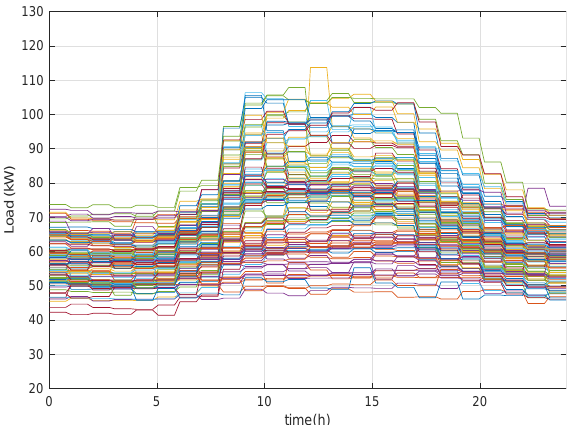
Figure 3. Sample of hourly demand profiles in the data set. Similarly, photo-voltaic generation profiles are extracted form the data-base presented in [18]. In Figure 4, the daily generation profiles are reported for one year. Each color represents a different day. Please note that the daily peak production can rise up to 83 kW.